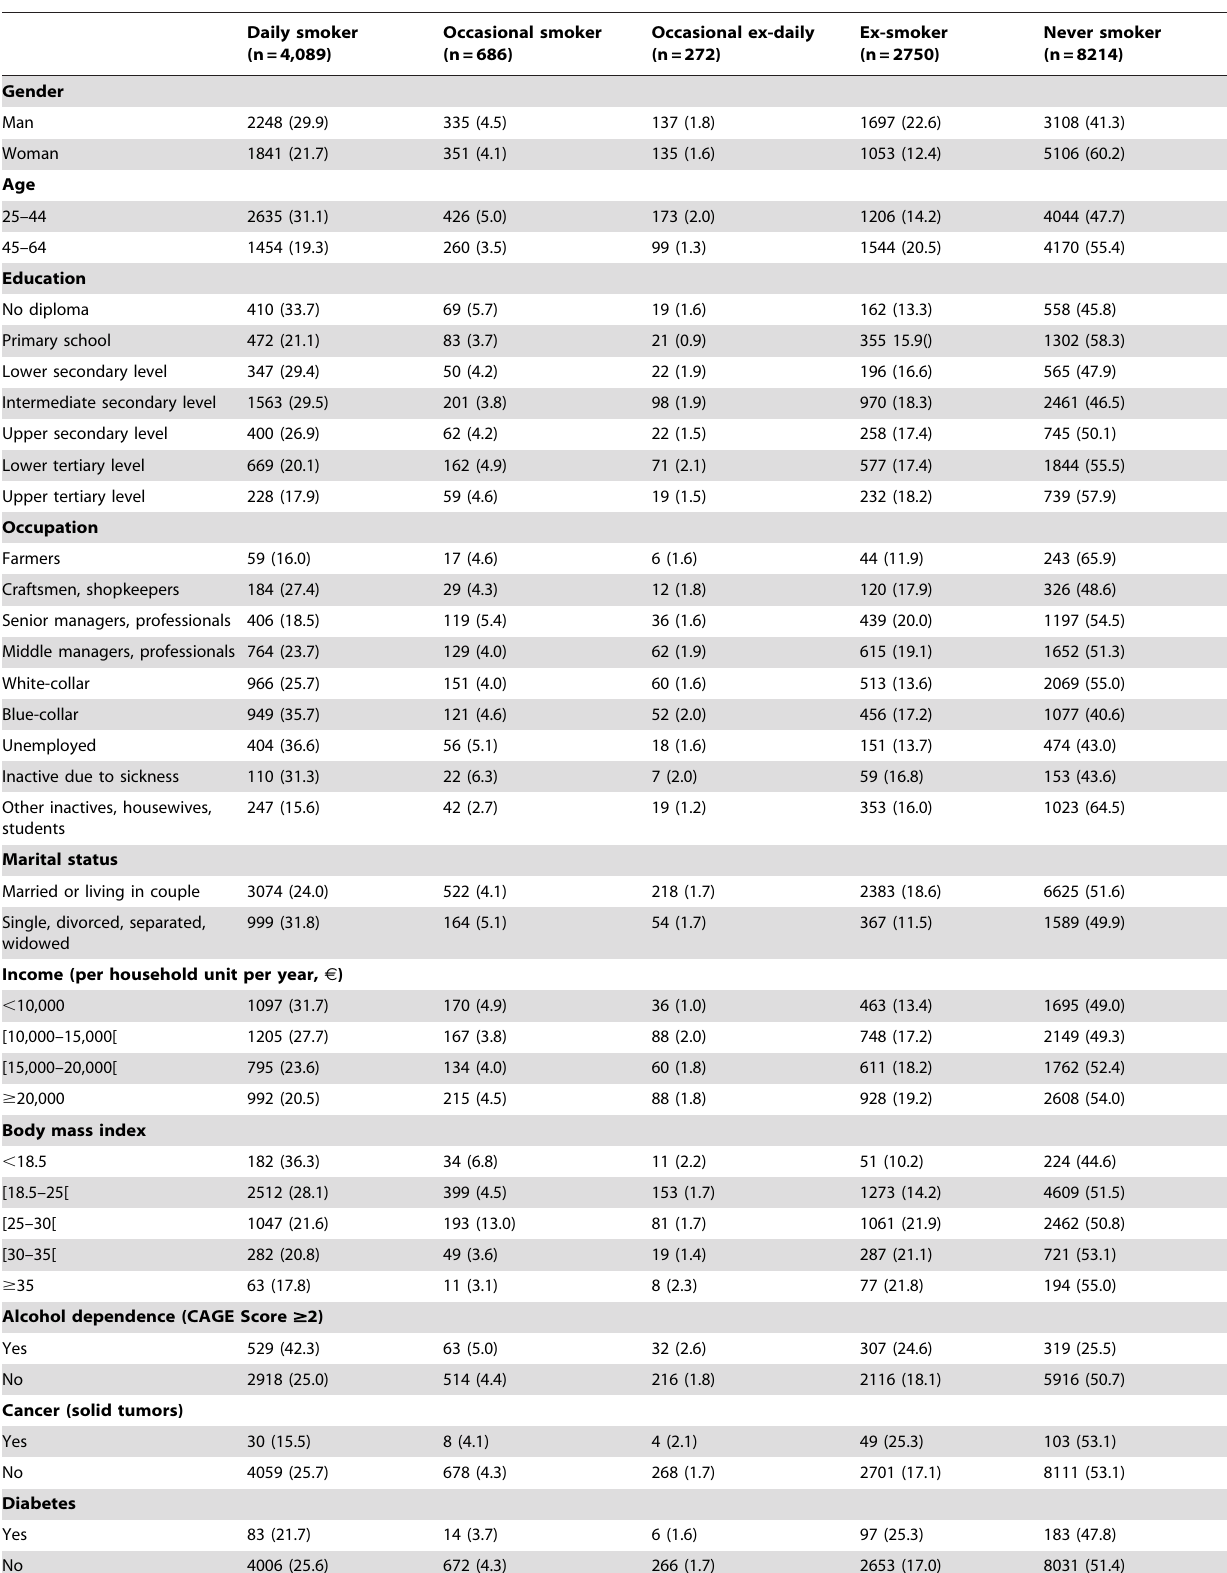
Table 1. Characteristics of 25–65 year-old subjects included in the study (n= 16,011), according to smoking